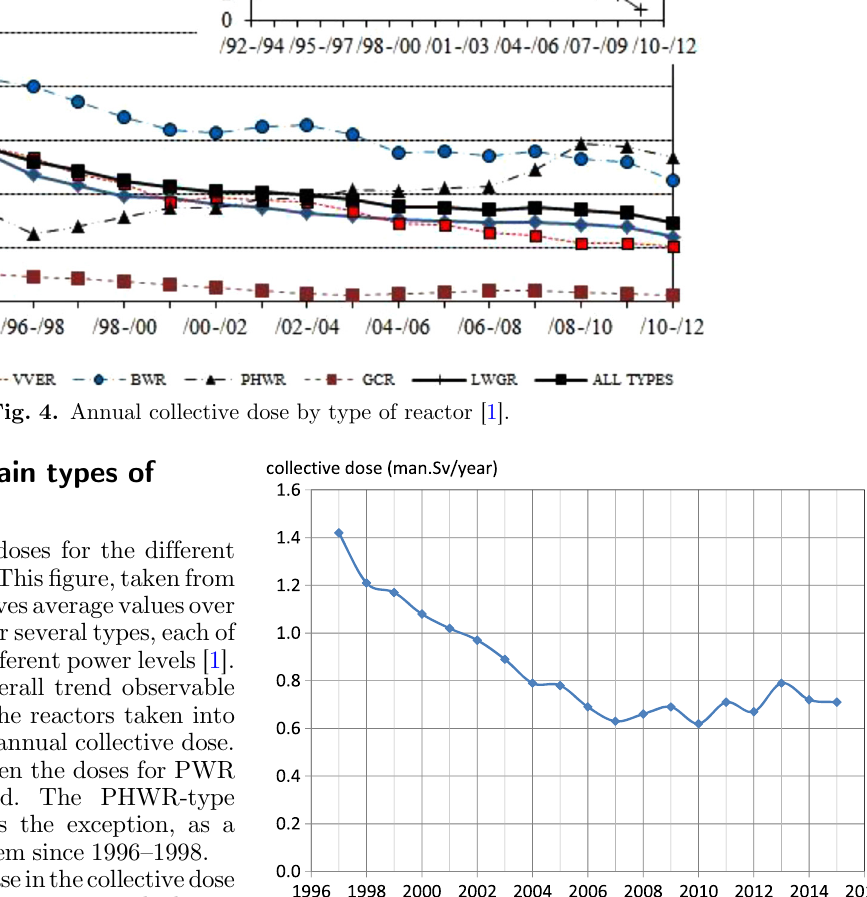
Fig. 5. Average annual collective dose per reactor in the French fl eet [10 –